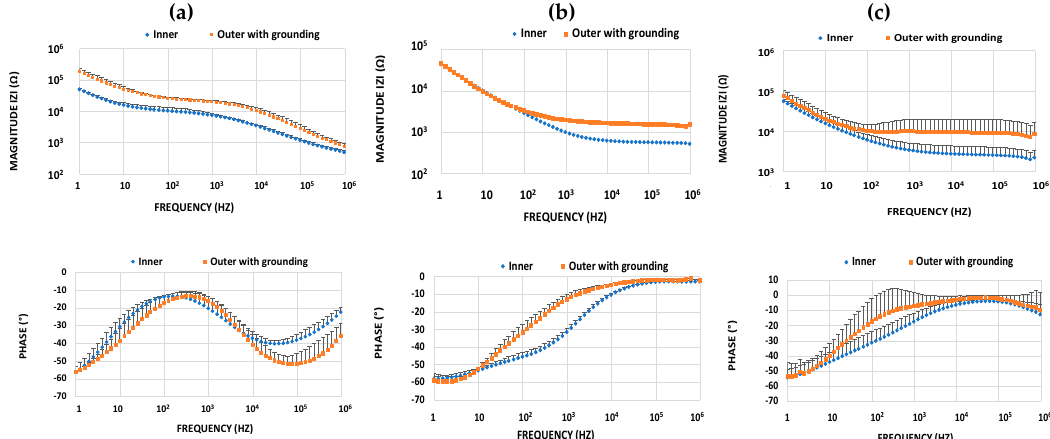
Figure 8. Bode plot (magnitude, phase) comparisons between the inner and outer with grounding configurations separately for ( a ) buccal mucosa, ( b ) muscle, and ( c ) fat. Data represent mean values and error bars indicate the standard deviation of the mean in one direction .